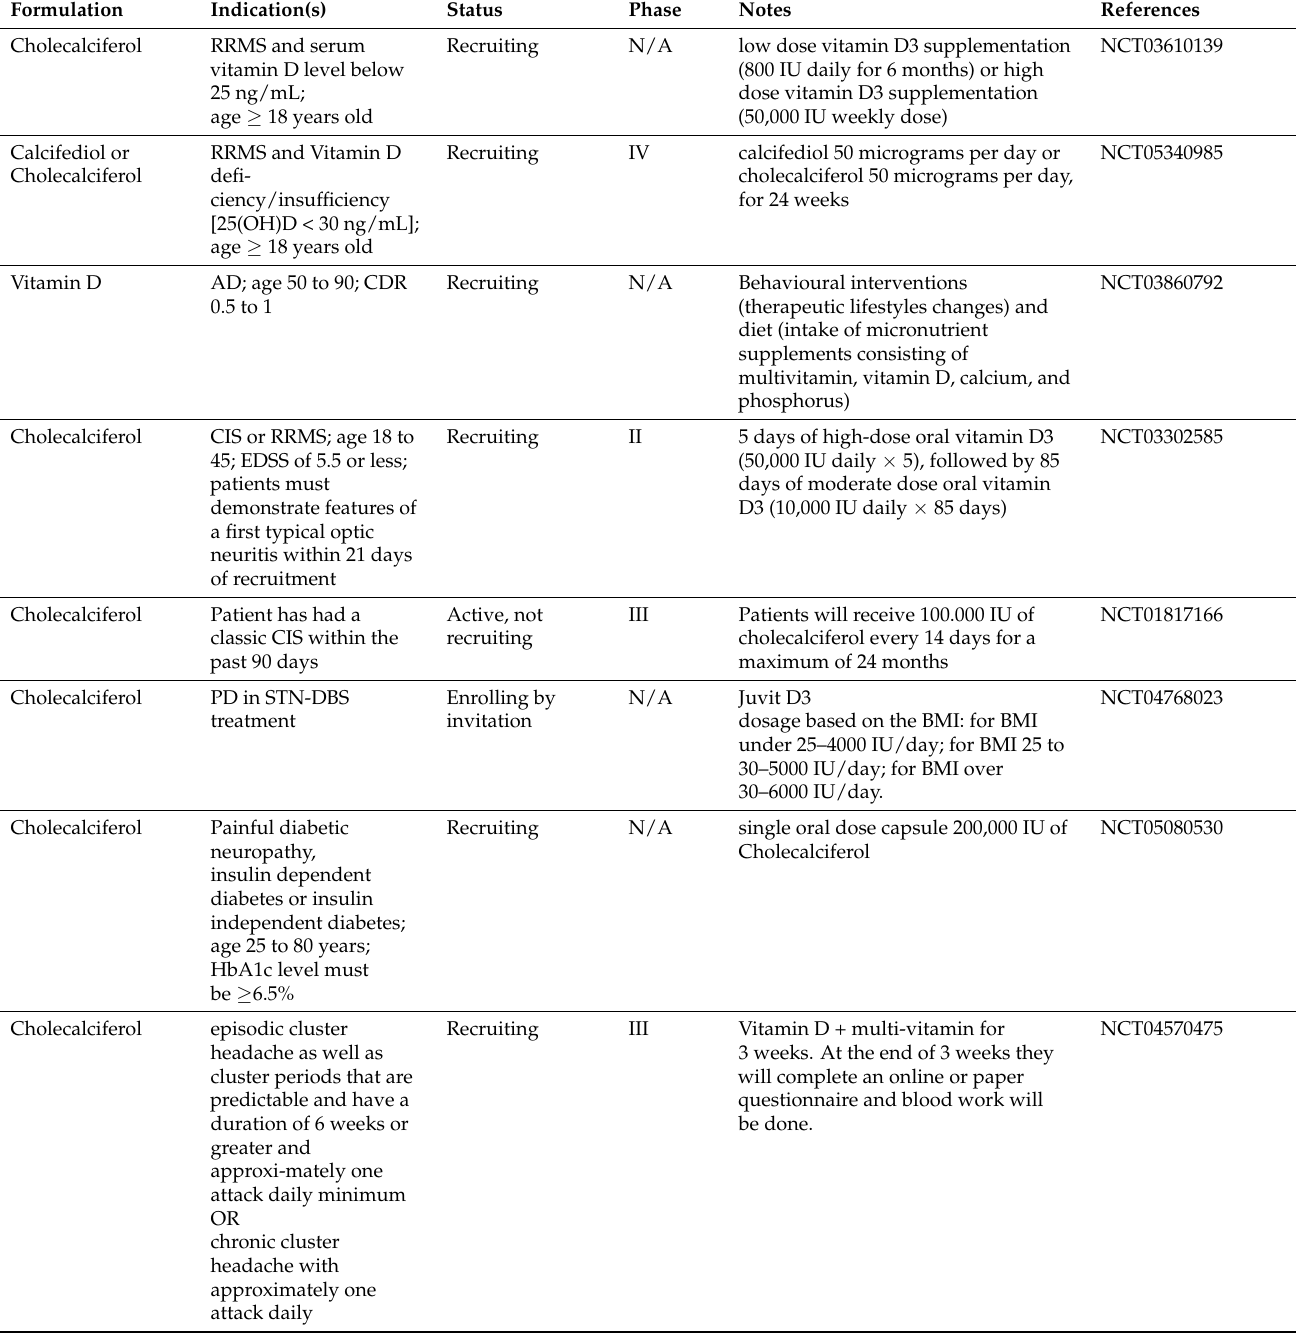
Table 1. Ongoing clinical trials exploring the effect of vitamin D supplementation in neurological diseases. AD Alzheimer’s disease; BMI body mass index; CDR Clinical Dementia Rating; CIS clinically isolated syndrome; EDSS Expanded Disability Status Scale; FA fatty acids; GMFCS Gross Motor Function Classification System; HbA1c haemoglobin A1c; IU international unit; PD Parkinson’s disease; RRMS relapsing-remitting multiple sclerosis; STN-DBS subthalamic nucleus-deep brain stimulation. To convert 25(OH)D from ng/mL to nmol/L the value is multiplied by